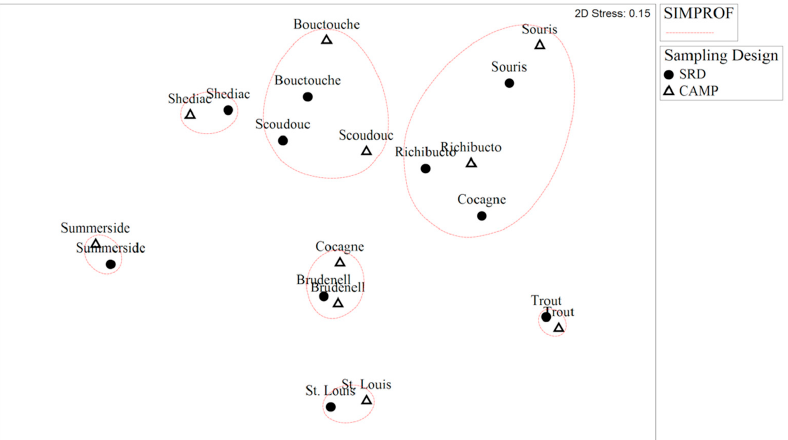
Figure 3. non-metric Multidimensional Scaling ordination plot of square-root transformed nekton data averaged over sampling design (Community Aquatic Monitoring Program [CAMP] vs. Stratified Random Design [SRD]) within each estuary. Ellipses represent the estuary groupings identified as significant by the SIMPROF test. Significant differences were detected among nekton assemblages at different estuaries (PERMANOVA pseudo-F = 12.95, p = 0.0001), but there was no significant difference between sampling designs (F = 1.44, p = 0.2073). However, the degree of difference between the sampling designs was somewhat dependent on the estuary (marginal interaction between Estuary x Sampling Design; F = 1.28, p = 0.0475). Therefore, differences between the sampling designs within each estuary were examined with pairwise tests. Significant differences were detected between the sampling designs only within Shediac, ( t = 1.527, p = 0.035), and Cocagne ( t = 1.819, p = 0.002) (Table 3). The difference detected in Cocagne supports the findings of the cluster analysis and nMDS ordinations. Pair-wise tests were also performed to look at differences between estuaries within each sampling design (Table 4). Significant differences were detected between all estuaries within both sampling designs except between Cocagne and Richibucto within the SRD sampling design ( t = 1.27, p = 0.173). Table 3. Permutational-MANOVA (PERMANOVA) pair-wise test results for factor Sampling Design within factor Estuary for nekton data collected from the Community Aquatic Monitoring Program (CAMP) and Stratified Random Design (SRD) stations. Estuary